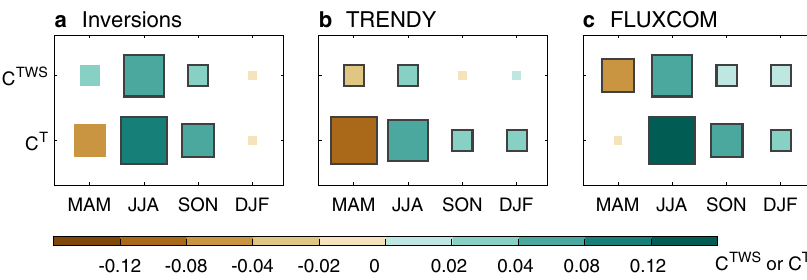
Fig. 3 C TWS and C T in the northern extra-tropics during four seasons. C TWS and C T indicate contributions to the global correlations of interannual variability of net ecosystem exchange (NEE IAV ) against terrestrial water storage (r TWS ) and temperature (r T ), respectively. NEE IAV is estimated by atmospheric inversions ( a ), DGVMs from the TRENDY project in simulation S2 (NEE output) ( b ), and FLUXCOM models ( c ). The four seasons are boreal spring (MAM, March – May), summer (JJA, June – August), autumn (SON, September – November), and winter (DJF, December and January – February). Positive values of C TWS or C T mean that removing the seasonal NEE IAV would reduce the absolute value of the global correlation r TWS or r T . The larger rectangles indicate the higher absolute values of the C TWS or C T . For atmospheric inversions and FLUXCOM models, the black edges of the rectangles indicate that the signs of the C TWS or C T are the same among all models. For DGVMs from the TRENDY project, black edges of the rectangles indicate that the signs of C TWS or C T derived from more than 10 out of 14 models are consistent with those from the model ensemble